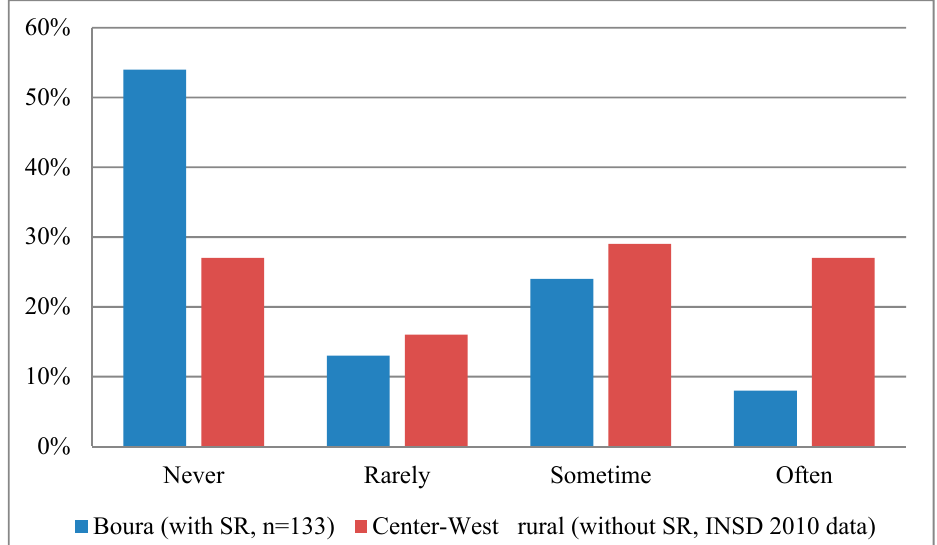
Figure 3. Responses to perceived household problems to satisfy food need: data source ([55]; mod- ified).